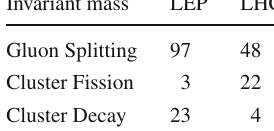
Table 3 Results for the tuned characteristic mass scales m 0 , in units of GeV, of our new model using the total invariant mass of a colour-singlet object for LEP and LHC tunes respectively